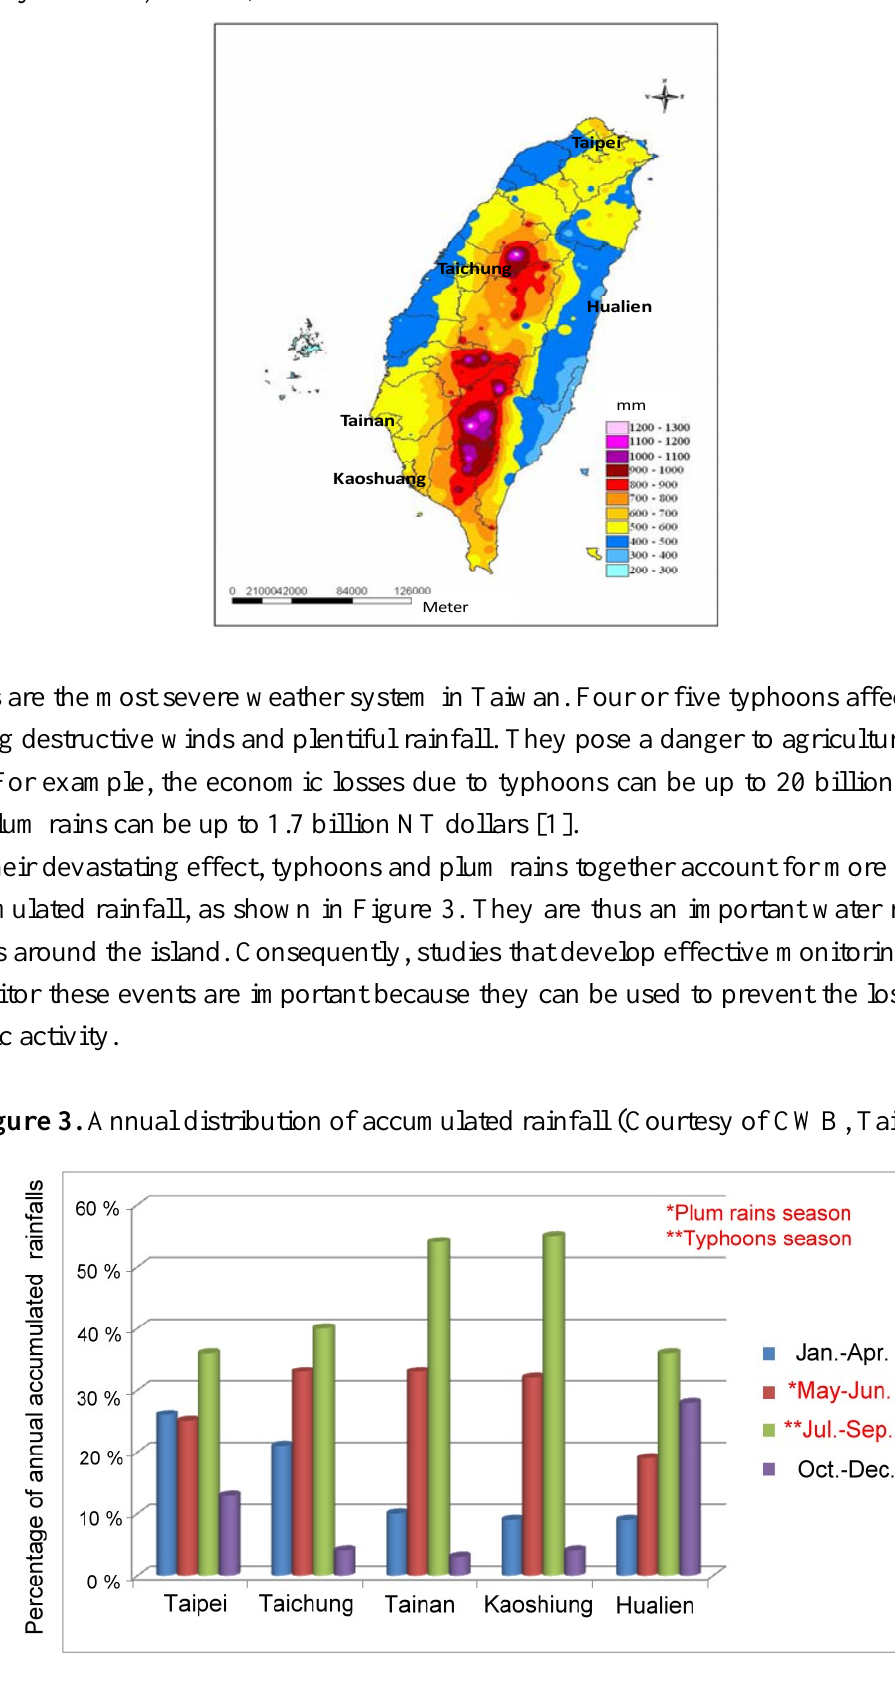
Figure 2. Average accumulated rainfall from 1992 to 2006 during the plum rain season (Courtesy of CWB, Taiwan).